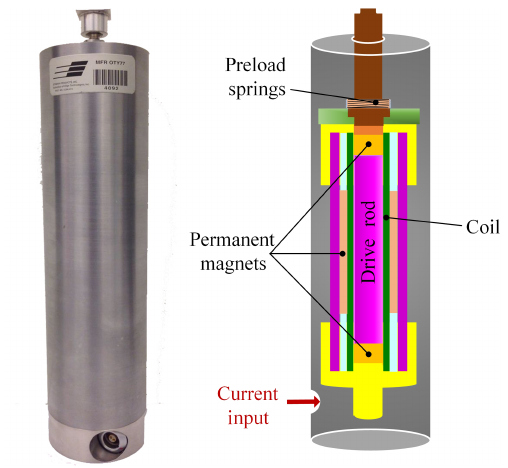
Figure 1. Schematic of the magnetostrictive